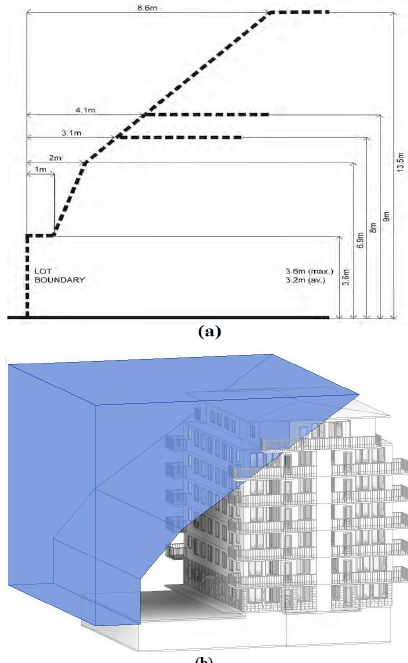
Figure 1. Setback regulation, a) in 2D (adapted from Melbourne Planning Scheme Ordinance, p. 1244); and b) modelled in